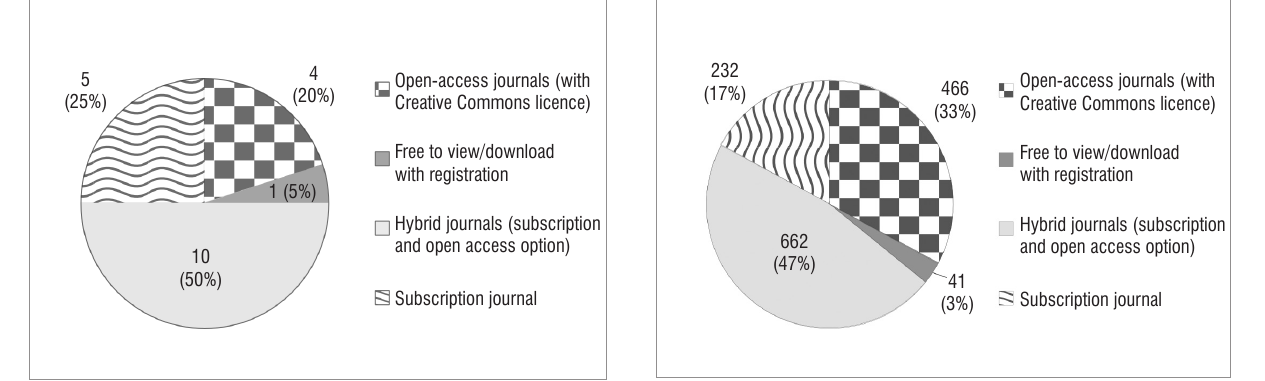
Figure 2: Number (%) in each category of the top 20 journals in which authors from the University of Cape Town publish.